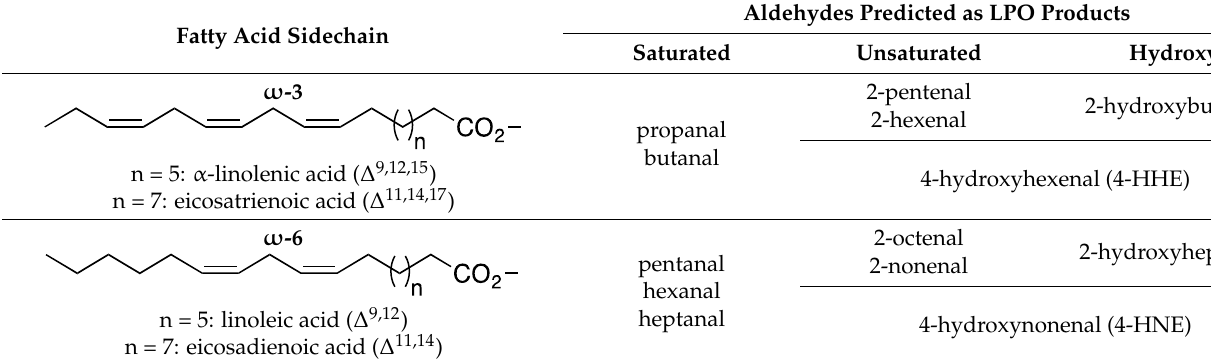
Table 2. Predicted LPO-derived aldehydes from a selection of unsaturated fatty acyl chains present in common ω -3 to ω -9 lung phosphatides.